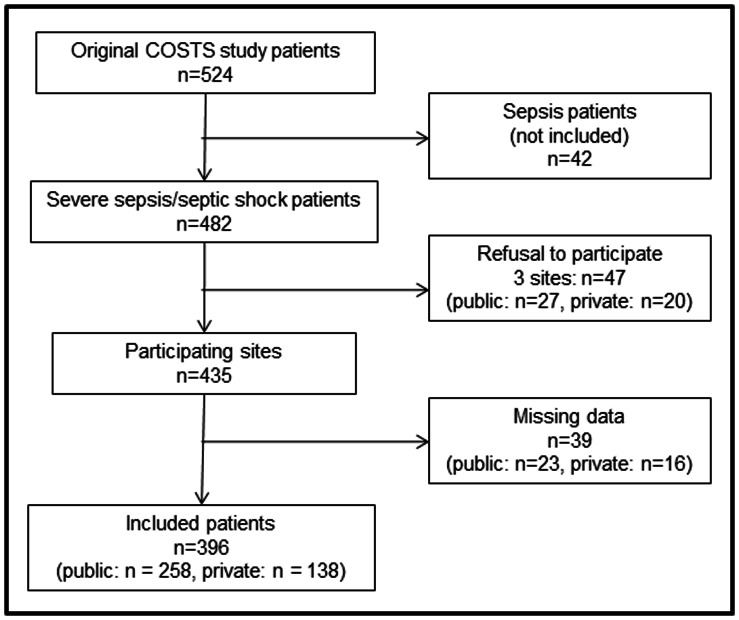
Study flowchart.